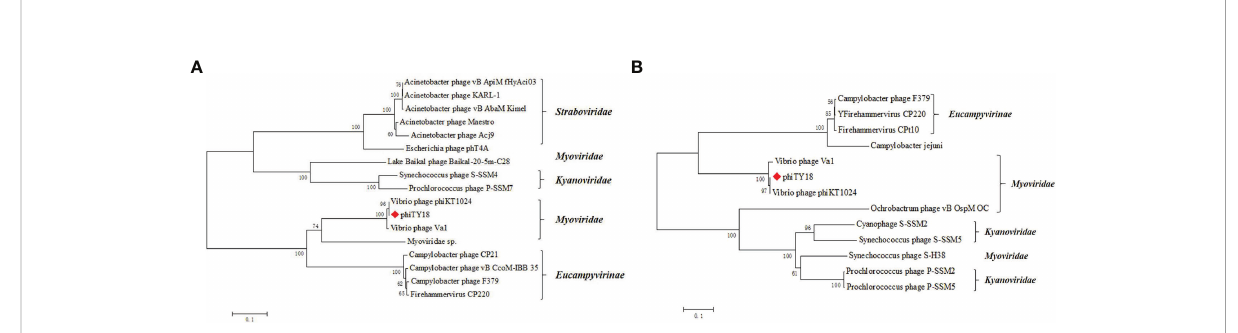
FIGURE 6 Phylogenetic tree based on major capsid protein ( MCP ) (A) and the terminase large subunit (B) . Phylogenetic trees were constructed by the neighbor-joining method with 1000 bootstrap replicates, following the ClustalW alignment of amino acid sequences using MEGA 7.0. The tree is drawn to scale, with branch lengths in the same units as those of the evolutionary distances used to infer the phylogenetic tree. The evolutionary distances were computed using the Poisson correction method and are in the units of the number of amino acid substitutions per site. The phage phiTY18 was labeled with a red diamond-shaped.